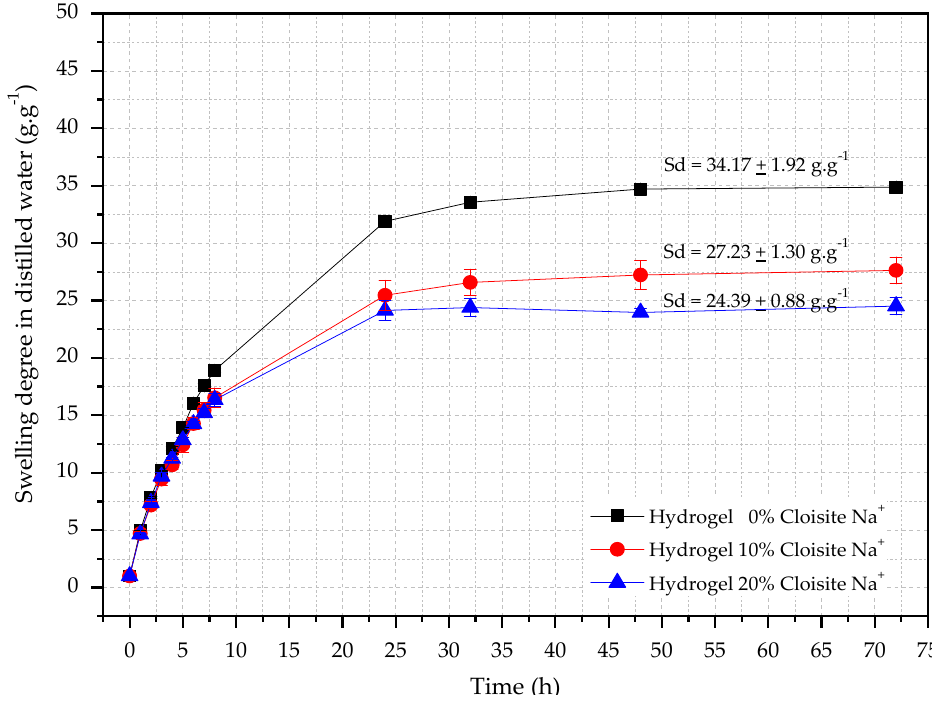
Figure 1. Swelling curves as a function of time for hydrogels with different Cloisite-Na + concentration in distilled